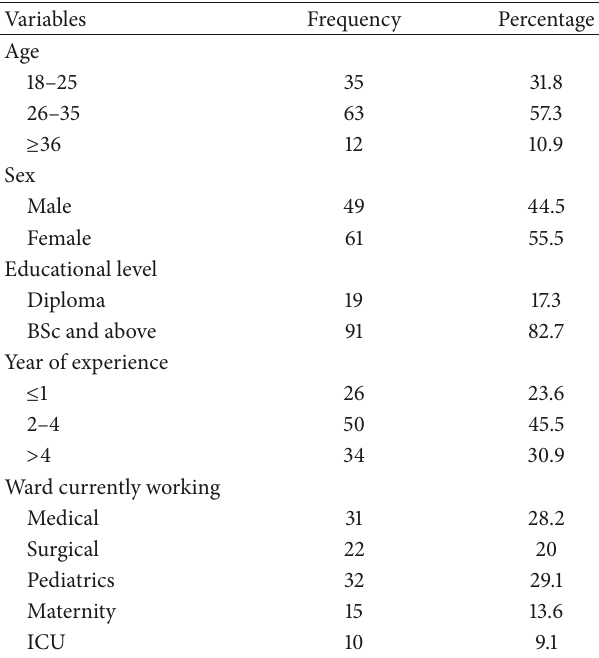
Table 1: Sociodemographic characteristic of nurses in Hiwot Fana Specialized University Hospital [HFSUH], Harar, Eastern Ethiopia,